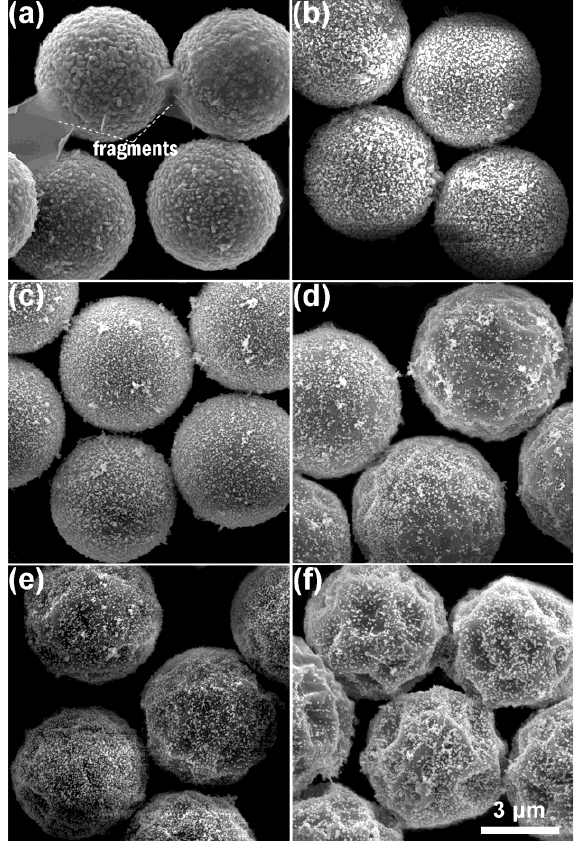
Figure 7. Impact of the MF 6 acid-treatment temperature on SEM images of the AgNP/MF 6 substrate: ( a ) 0, ( b ) 20, ( c ) 40, ( d ) 60, ( e ) 80 and ( f ) 100 °C were collected on the substrate incorporating